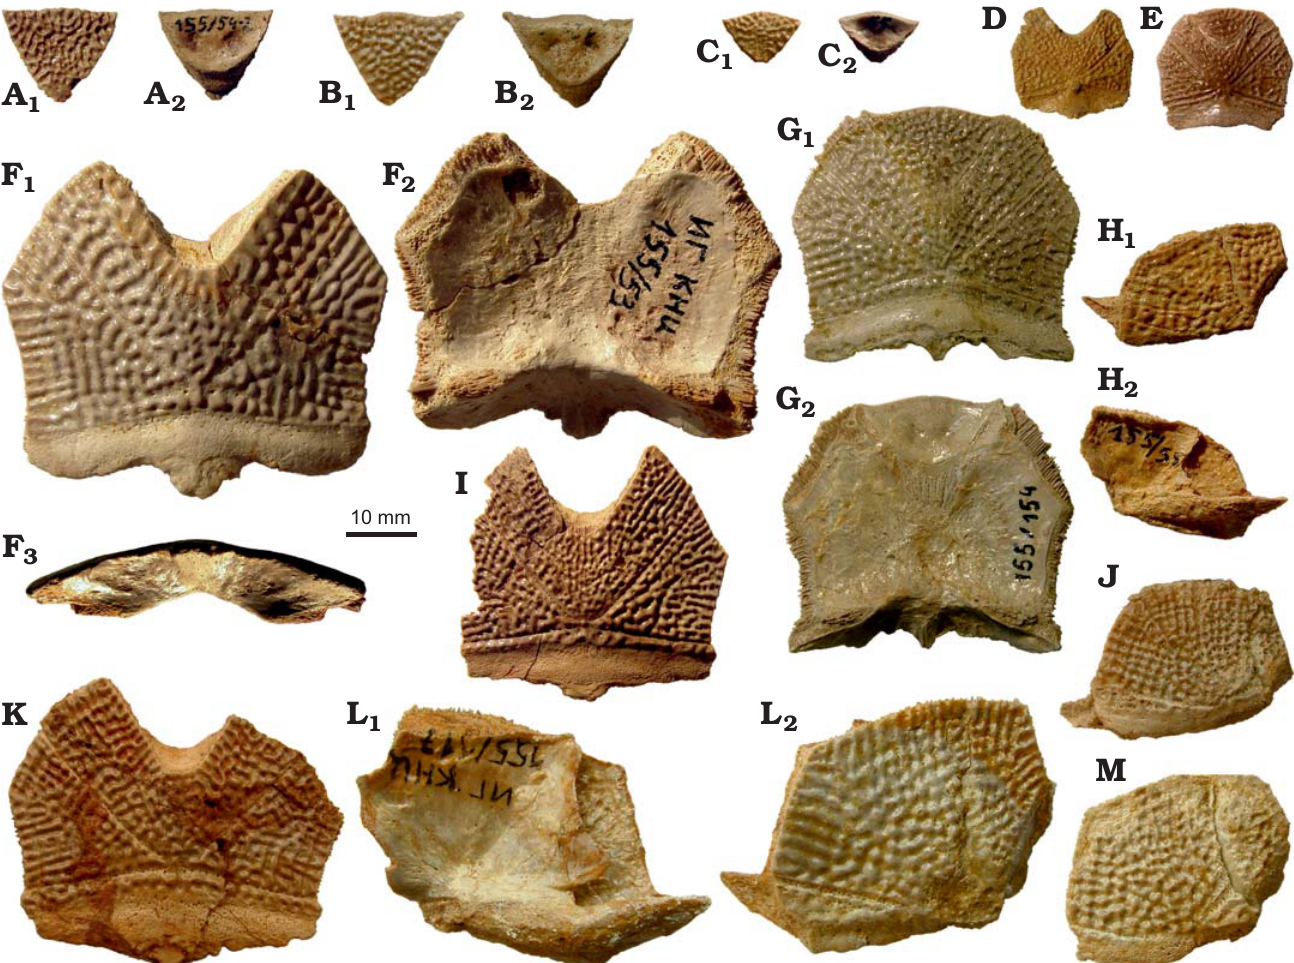
Fig. 6. Antiarchan fish Bothriolepis leptocheira jeremejevi (Rohon, 1900), Sosnogorsk locality, Sosnogorsk Formation, lowermost Famennian, postpineal (A–C, E, G), nuchal (D–G, I, K–M), and paranuchal (H, J, L, M) plates of the head shield. A . IG KSC 155/54-2, disconnected from the Nu IG KSC 155/54-1, in dorsal (A 1 ) and visceral (A 2 ) views. B . IG KSC 155/146 in dorsal (B 1 ) and visceral (B 2 ) views. C . IG KSC 155/155 in dorsal (C 1 ) and visceral (C 2 ) views. D . IG KSC 155/58 in dorsal view. E . Articulated plates IG KSC 155/118 in dorsal view. F . IG KSC 155/53 in dorsal (F 1 ), visceral (F 2 ), and posterior (F 3 ) views. G . Articulated plates IG KSC 155/154 in dorsal (G 1 ) and visceral (G 2 ) views. H . IG KSC 155/55 in dorsal (H 1 ) and visceral (H 2 ) views. I . IG KSC 155/54-1 from the same individual as plate in A, in dorsal view. J . IG KSC 155/119 in dorsal view. K . IG KSC 155/56 in dorsal view. L . IG KSC 155/117 in visceral (L 1 ) and dorsal (L 2 ) views. M . IG KSC 155/125 in dorsal